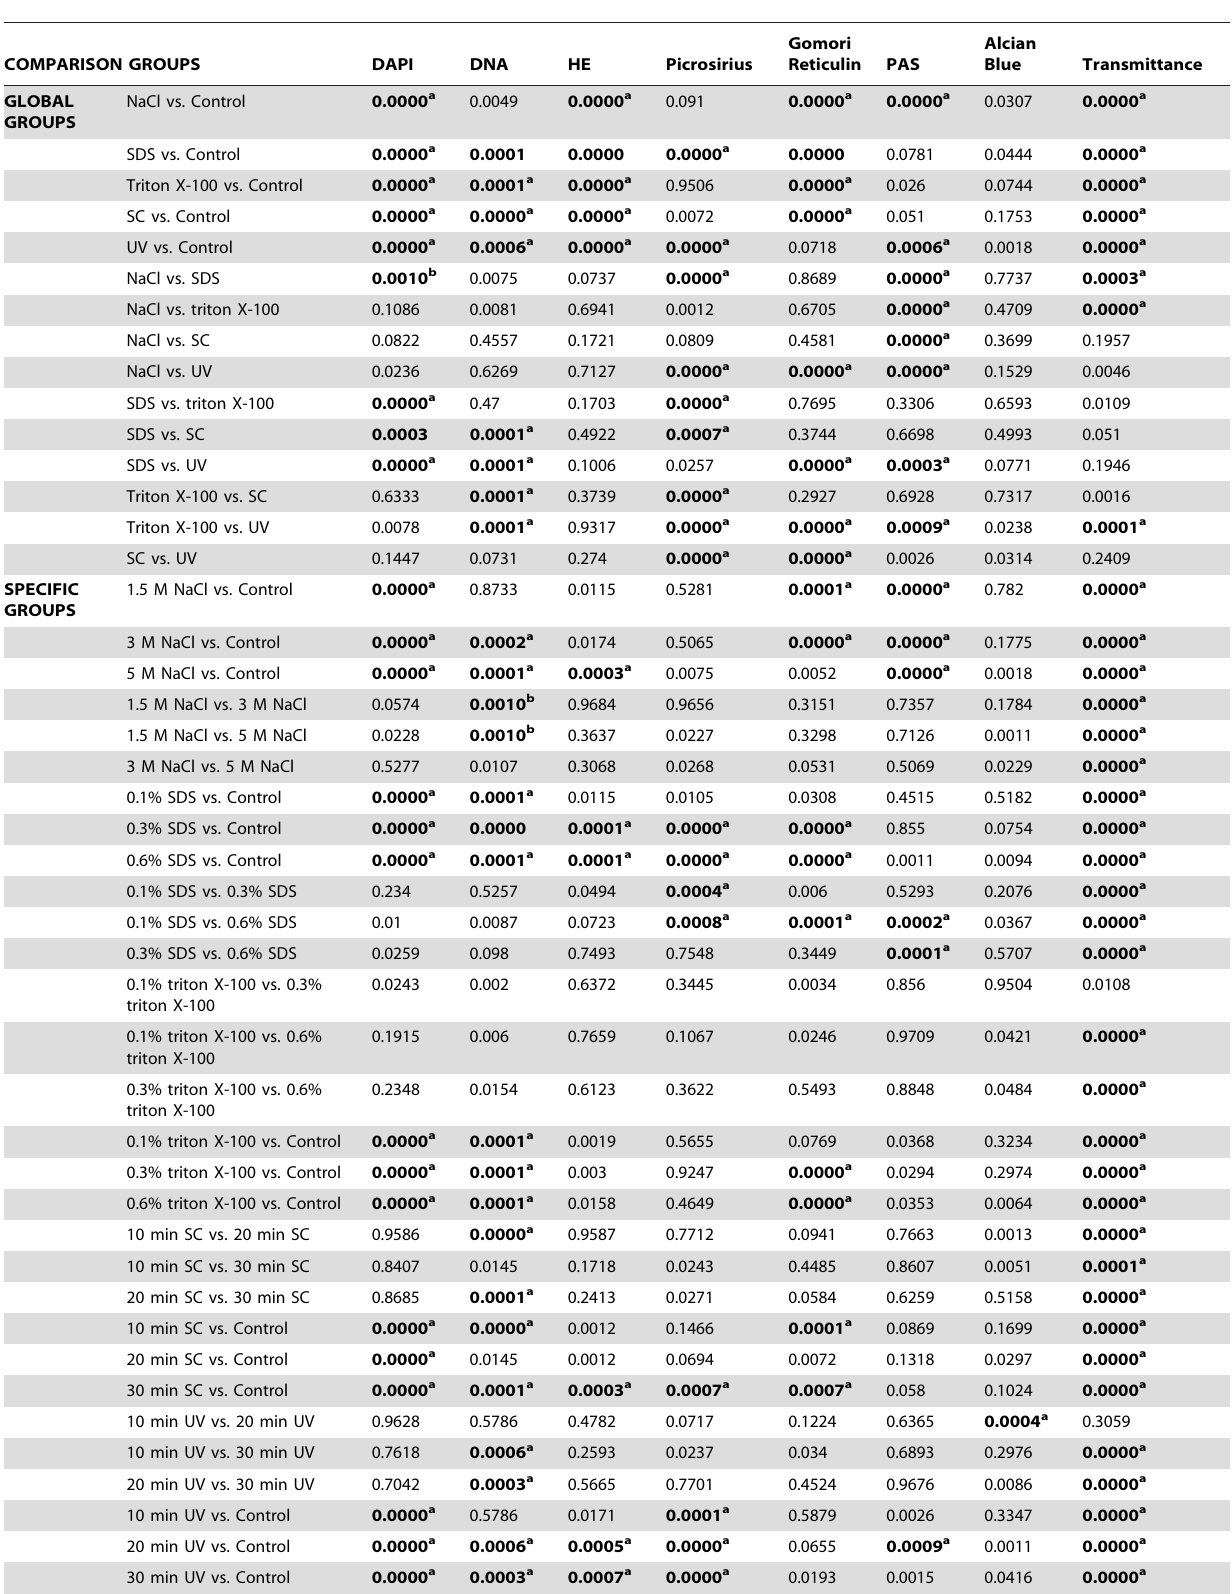
Table 2. Statistical p values corresponding to the comparison of the results obtained for each decellularization method and for each